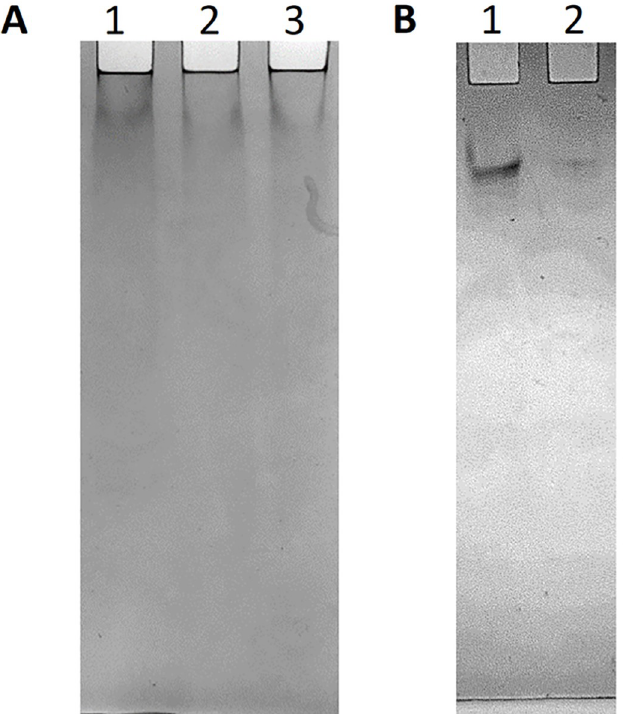
Fig 4. Clear native PAGE analysis of the RBBP6-p53BD. Clear native PAGE analysis of purified RBBP6-p53BD. (A) : Tris-HCl buffer, with pH 8.3. Lane 1 is the RBBP6-p53BD in 50 mM sodium phosphate, pH 7. Lane 2 is the RBBP6-p53BD in 50 mM sodium phosphate, pH 7 after being heated to and cooled from 90˚C to 20˚C, as described in section 2.8 . Lane 3 is the RBBP6-p53BD in 50 mM sodium phosphate, pH 7 with 2 M urea. (B) : Imidazole-HEPES buffer, pH7.4. Lane 1 is the RBBP6-p53BD in 50 mM sodium phosphate, pH 7, and Lane 2 is the RBBP6-p53BD in 50 mM sodium phosphate, pH 7 after being heated to and cooled from 90˚C to 20˚C, as described in section 2.8 . Protein samples were not equalised before loading onto the